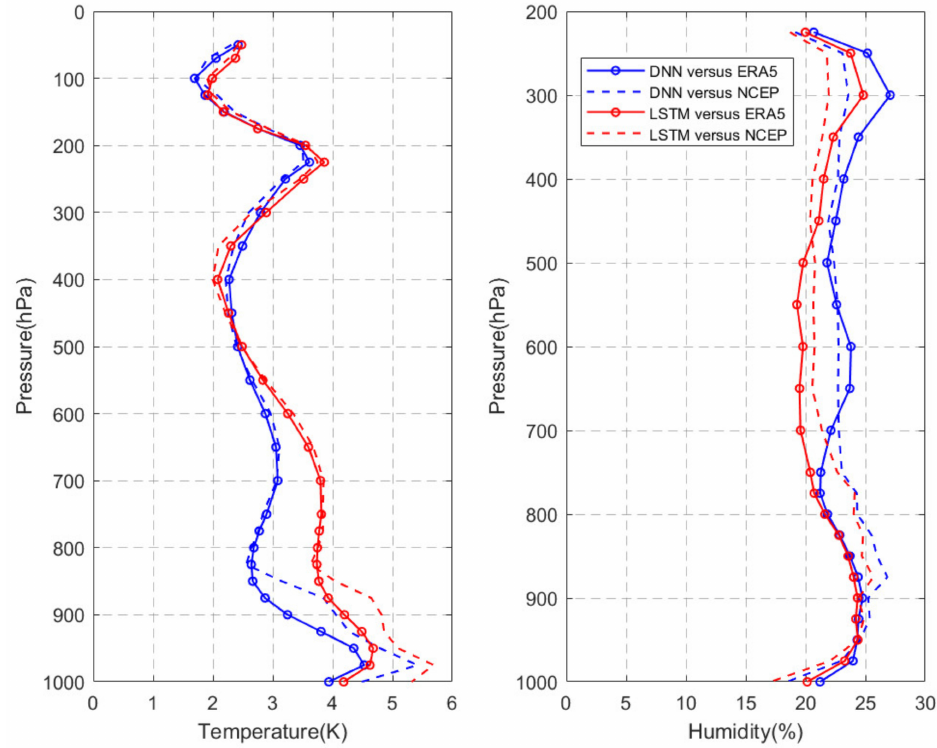
Figure 7. The retrieval RMSEs of the DNN-based model and LSTM-based model with respect to ERA5 and NCEP reanalysis data over sea ice in February